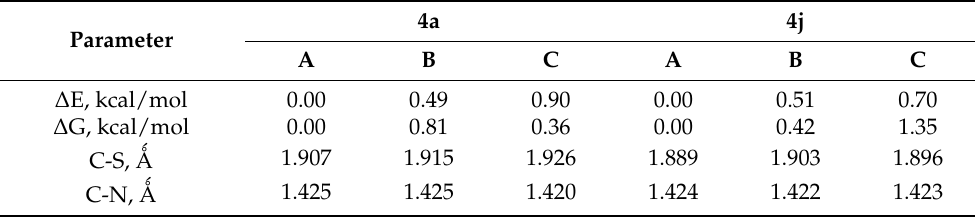
Figure 1. Newman projections of the most stable conformers of compounds 4a and 4j along the C-S bond. Table 3. Relative electronic energy ( ∆ E), Gibbs free energy ( ∆ G), C-S and C-N bond lengths in N-C-S fragment for three rotamers of compounds 4a and 4j in DMF solution a .